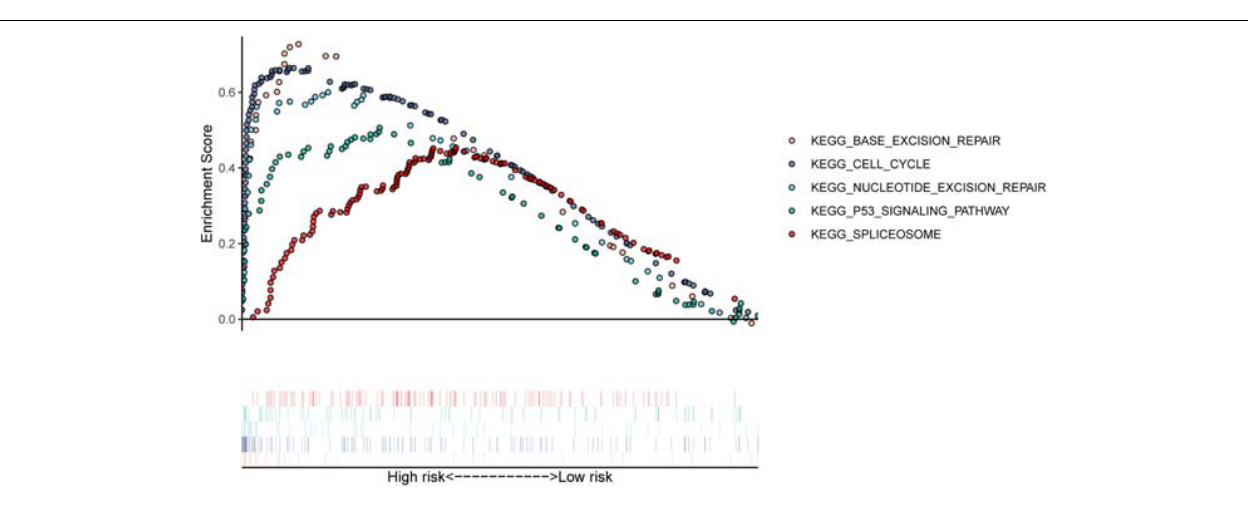
FIGURE 8 | The KEGG pathways were enriched in the high-risk group by performing the GSEA